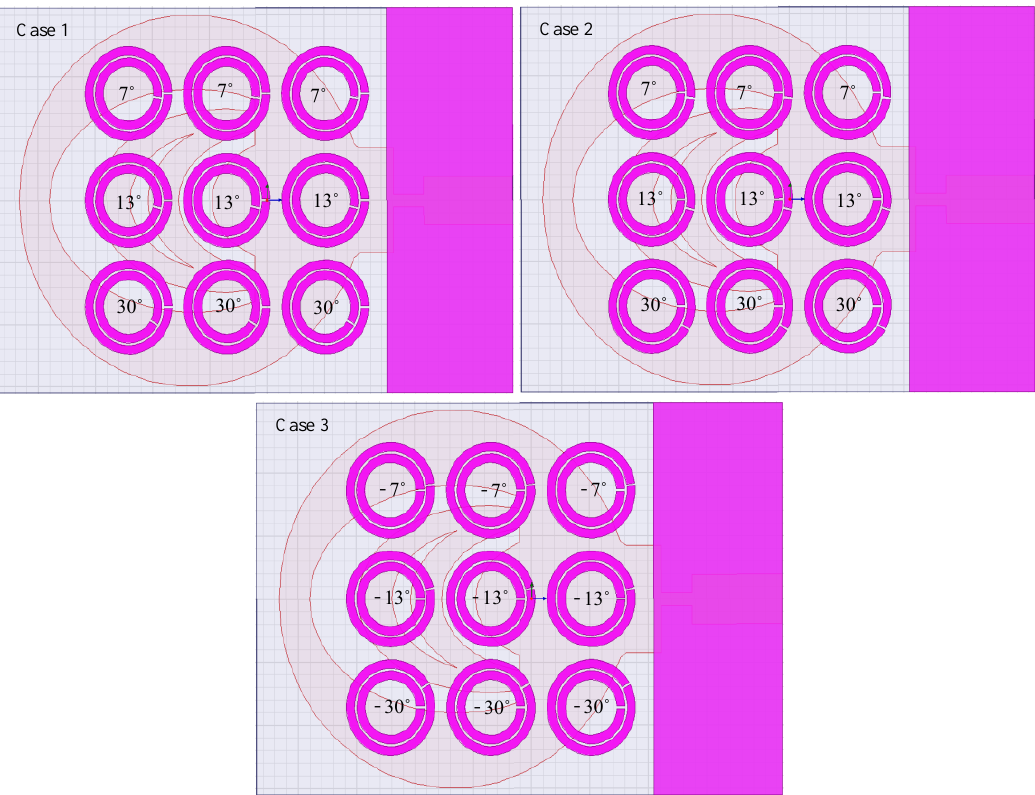
Figure 34. Inner and outer ring rotation for positive and negative angles.